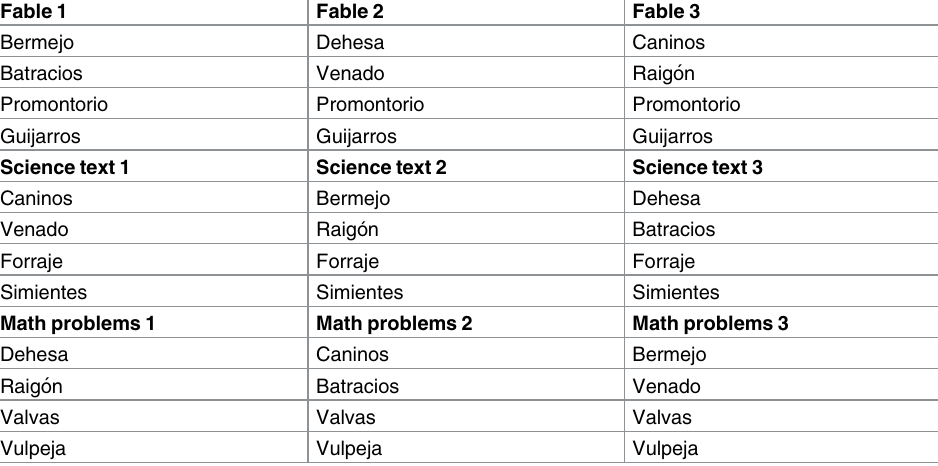
Table 1. Distribution of target words in the texts of the experimental set